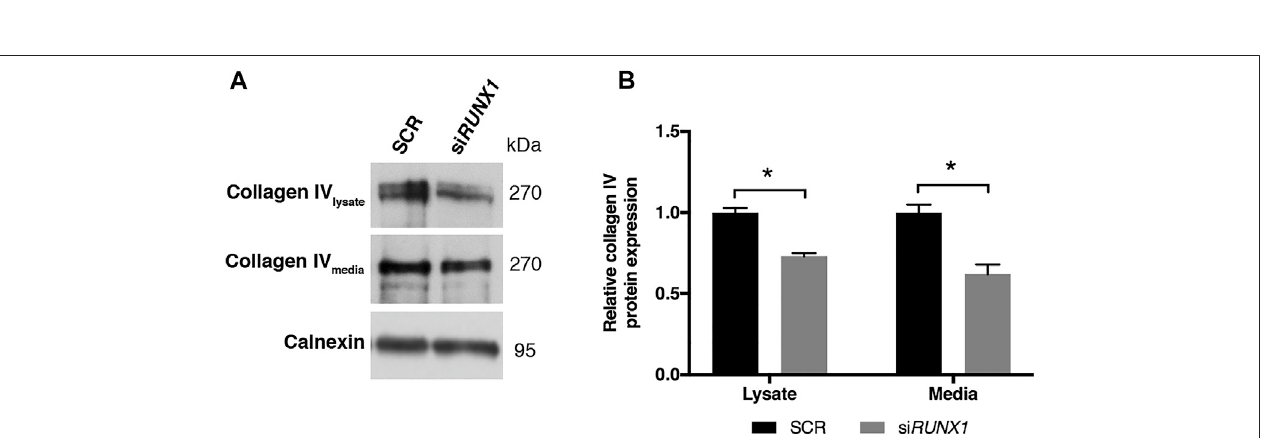
FIGURE 6 | RUNX1 silencing leads to a signi fi cant decrease of collagen IV protein in media of silenced trisomic samples. (A) Representative immunoblotting of collagen IV protein detected in cell lysates and culture media of SCR and si RUNX1 -treated DS-HFF samples. Calnexin was used as a loading control. (B) Densitometric analysisfromtwodifferentexperiments.IneachexperimentweusedtwooutofthethreeDS-HFFssamplesof Figure5 .Resultsareexpressedasrelativemeanvalues± SEM from two SCR and the two corresponding RUNX1 -silenced DS-HFFs. * p -value ≤